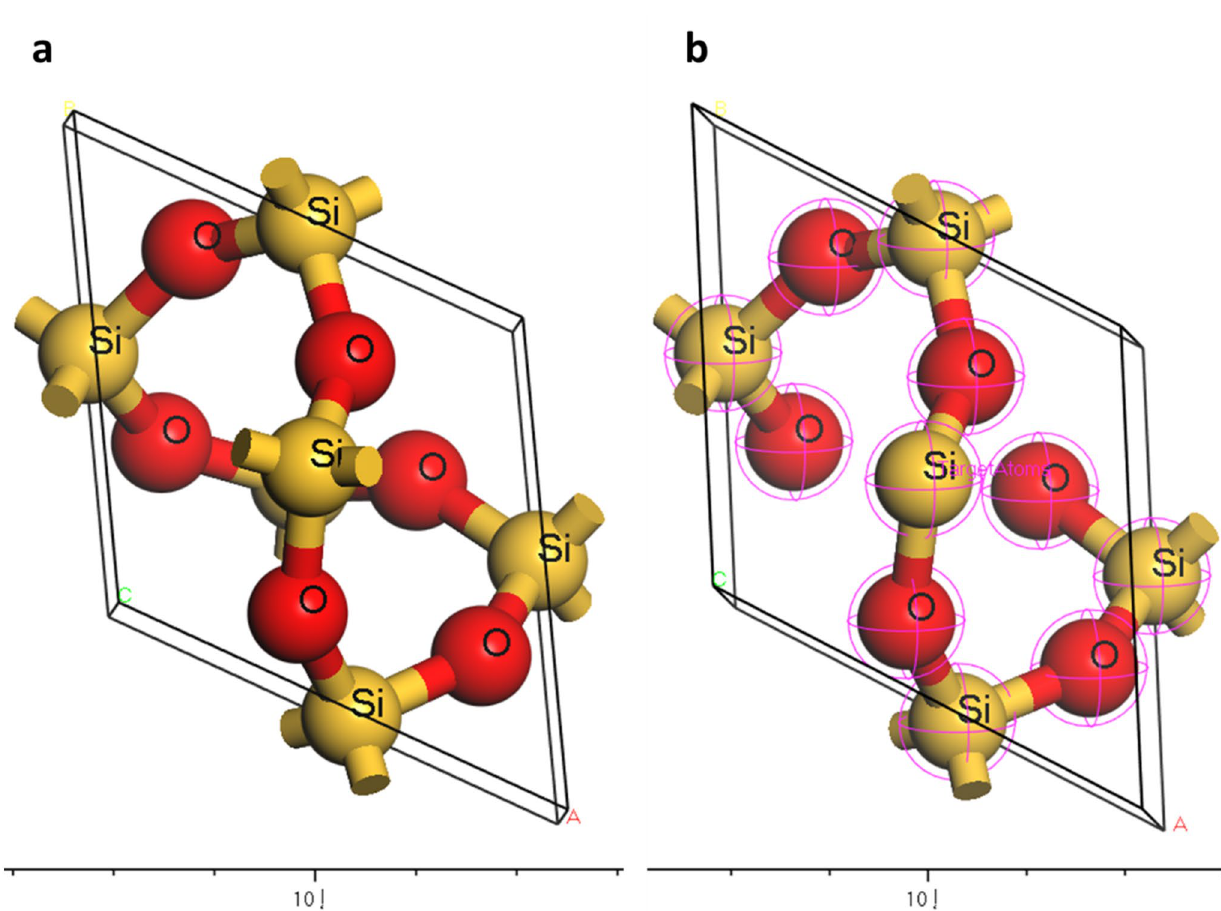
Fig. 3 The cell model of ( a ) ball and stick quartz model; ( b ) quartz surface cleaved at (001)